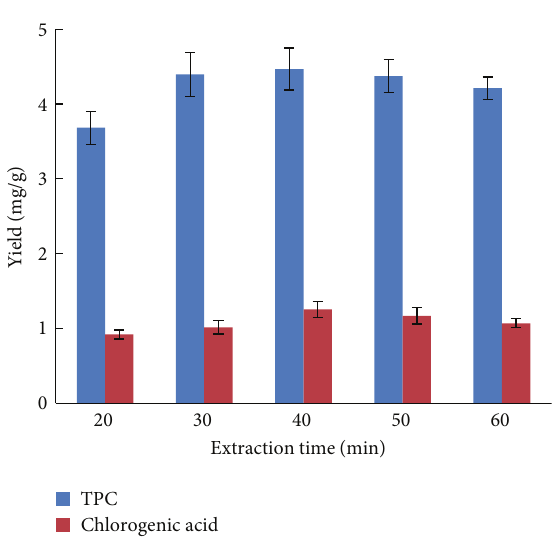
Figure 3: Effect of solid-liquid ratio on TPC and chlorogenic acid yield (ethanol concentration, 25%; extraction time, 30min; number of extractions, 1; 𝑛 = 5